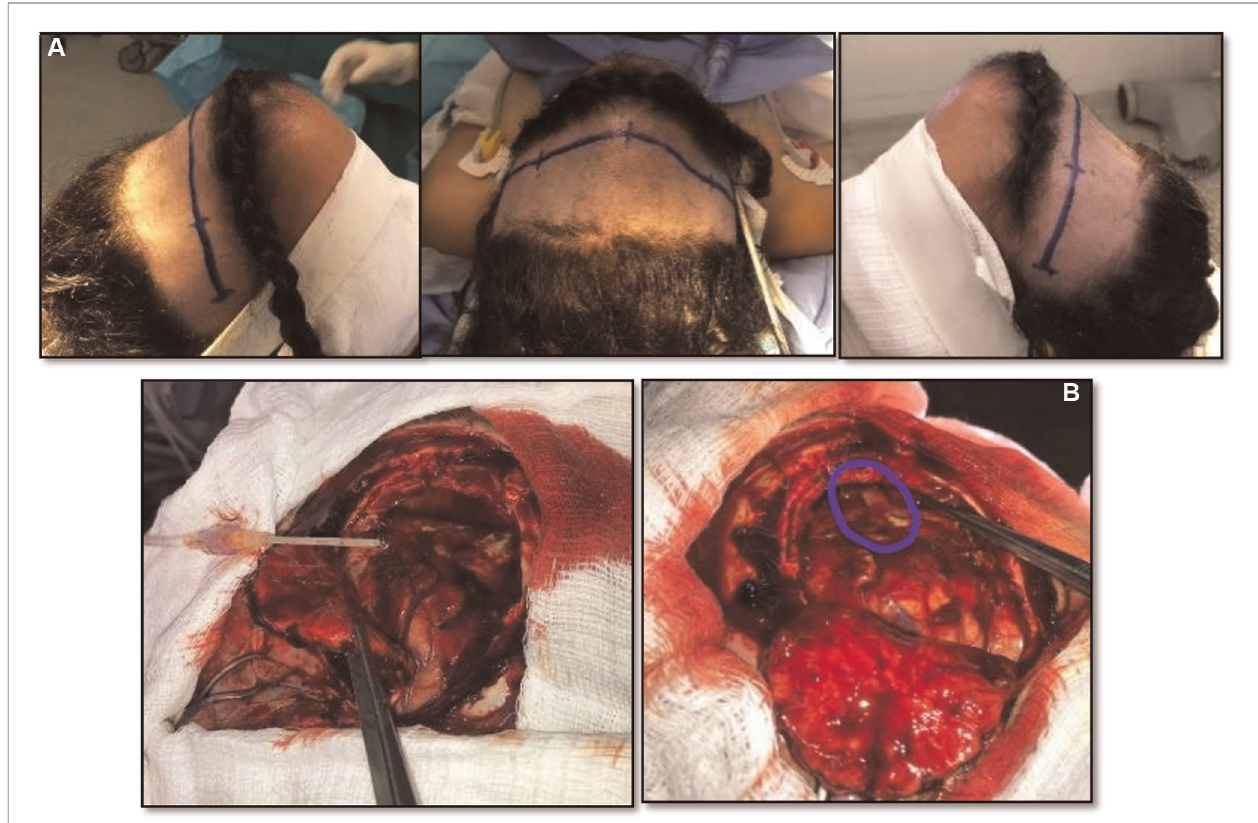
FIGURE 3 | ( A ) Positioning for surgical approach and marking of the bicoronal incision, evidencing the protuberance of the forehead by progressive swelling. ( B ) Intraoperative image after craniotomy with emphasis on fi stulous hole of communication with frontal sinus,